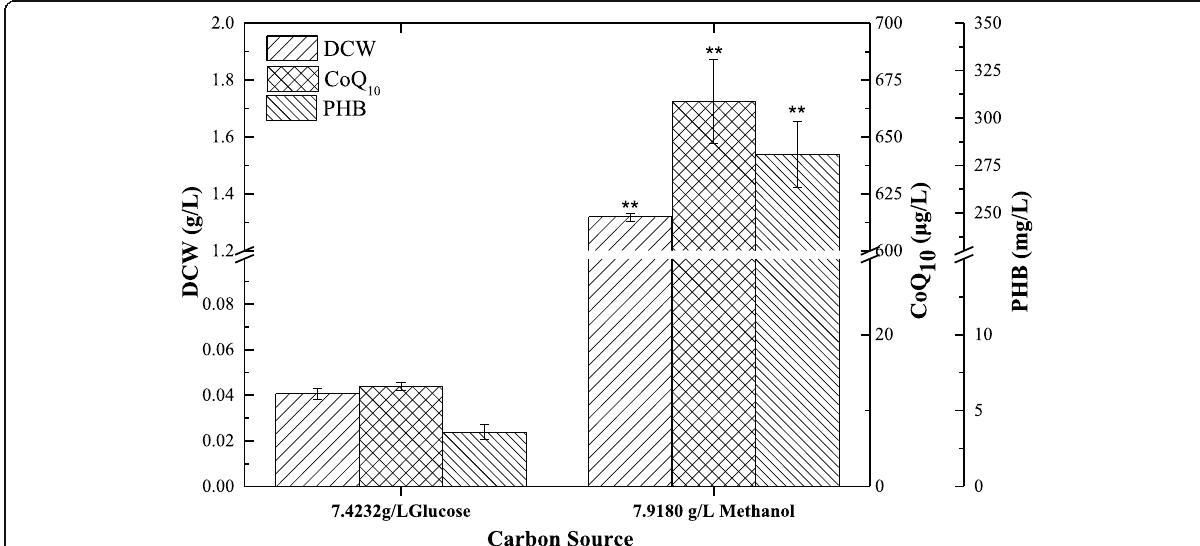
Fig. 3 Different effects of glucose and methanol (same carbon atom amount) on the strain XJLW cell growth and its yield of CoQ 10 and PHB. Significant differences from glucose group are indicated by * p < 0.05; ** p < 0.01